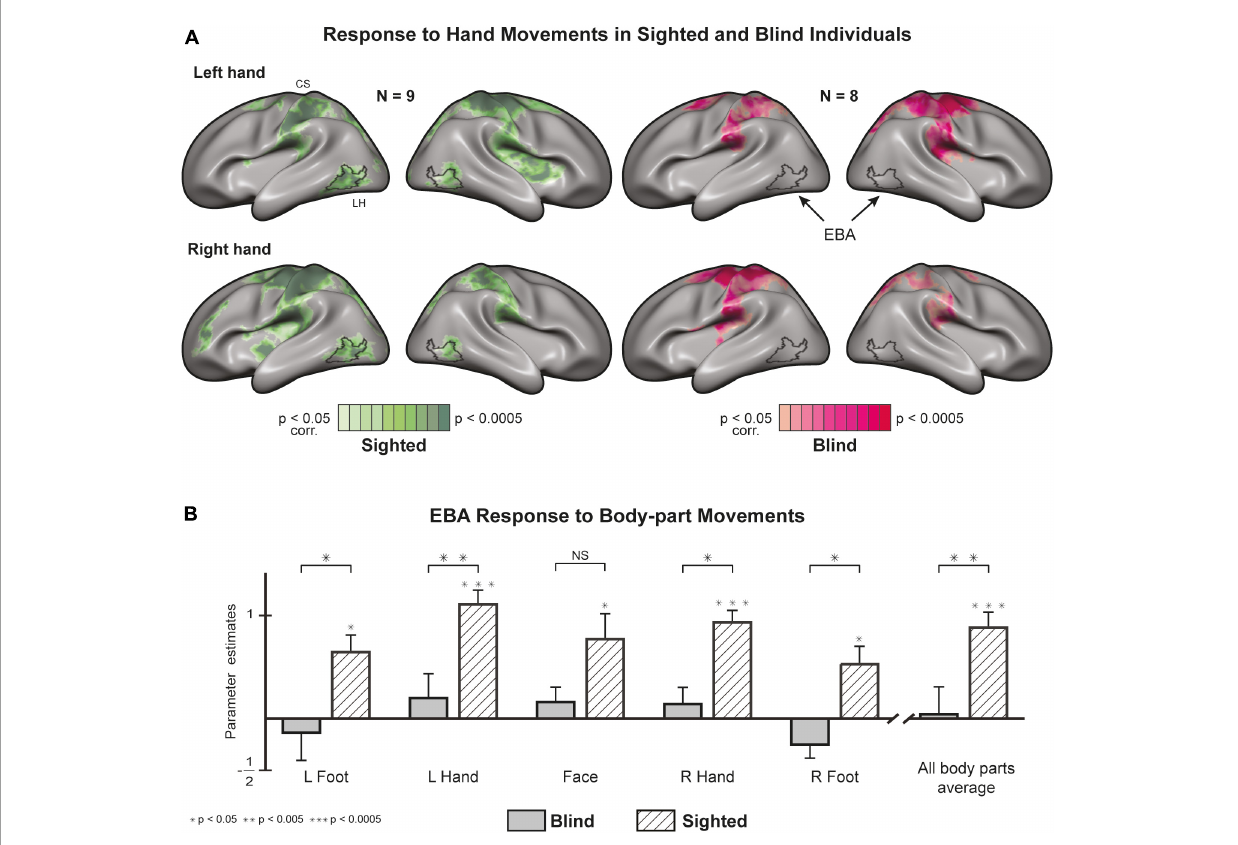
FIGURE1 Motor-evoked responses to body part movements (whole-brain and EBA localizer). (A) Whole-brain statistical parametric maps of hand movements, most commonly associated with EBA activity, plotted on both cortical hemispheres after cortex-based alignment [random effects General Linear Model (GLM)]. Hand movements recruit EBA in sighted individuals but not in blind individuals (see Supplementary Figure 5 for other body parts). EBA, Extrastriate Body Area; CS, central sulcus. (B) Regions of Interest (ROI) analysis of EBA response to various body parts. The region is significantly active in the sighted and not in the blind. A between-group analysis (random effects GLM, n = 17) reveals significant differences in the response to movements of the right foot, right hand, left foot, and left hand (for results in separate hemispheres, see Supplementary Figure 6